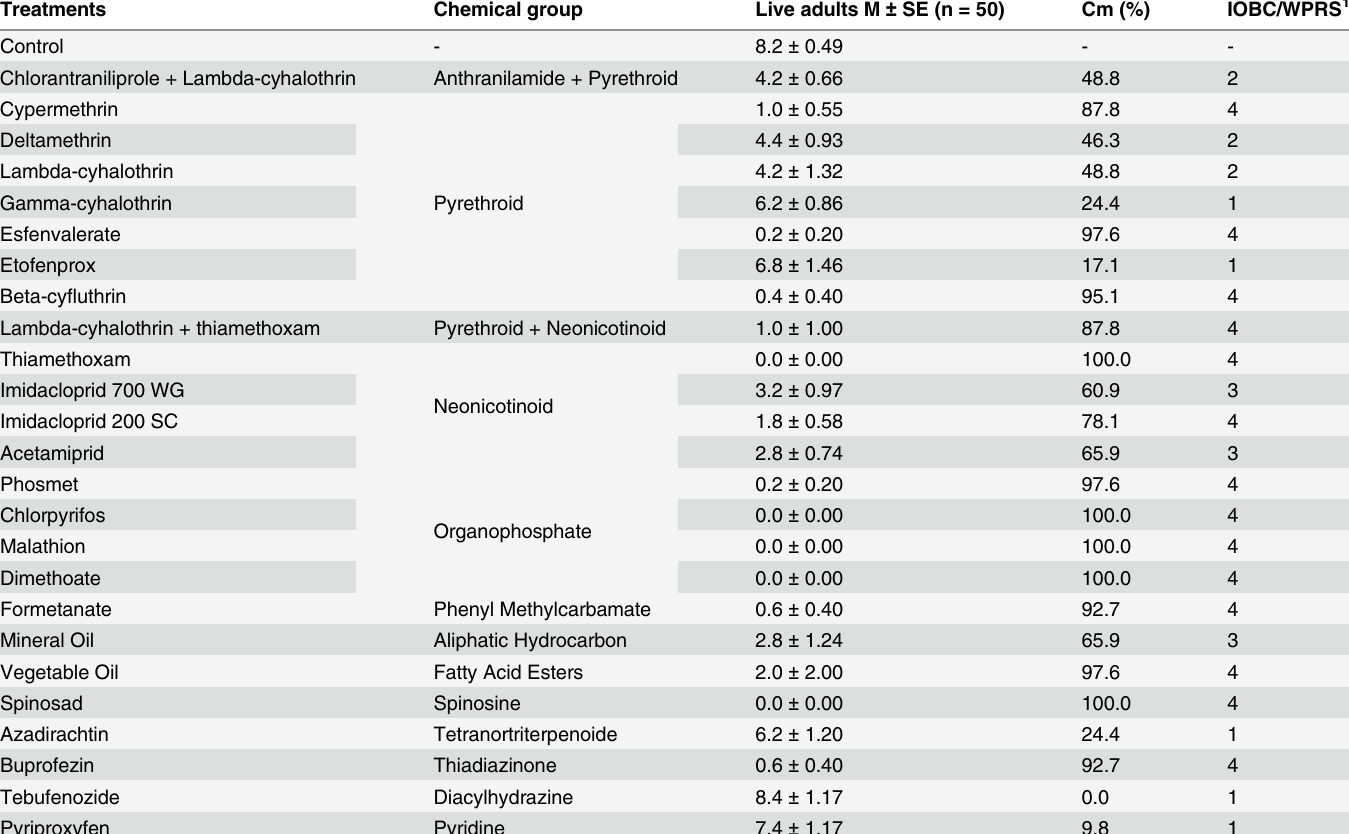
Table 2. Mean number of Tamarixia radiata live adults, Corrected mortality (Cm) and class of toxicity of the compounds according to IOBC/WPRS, under 25 ± 2° C, 70 ± 10% RH and photoperiod 14 L: 10 D h. Treatments